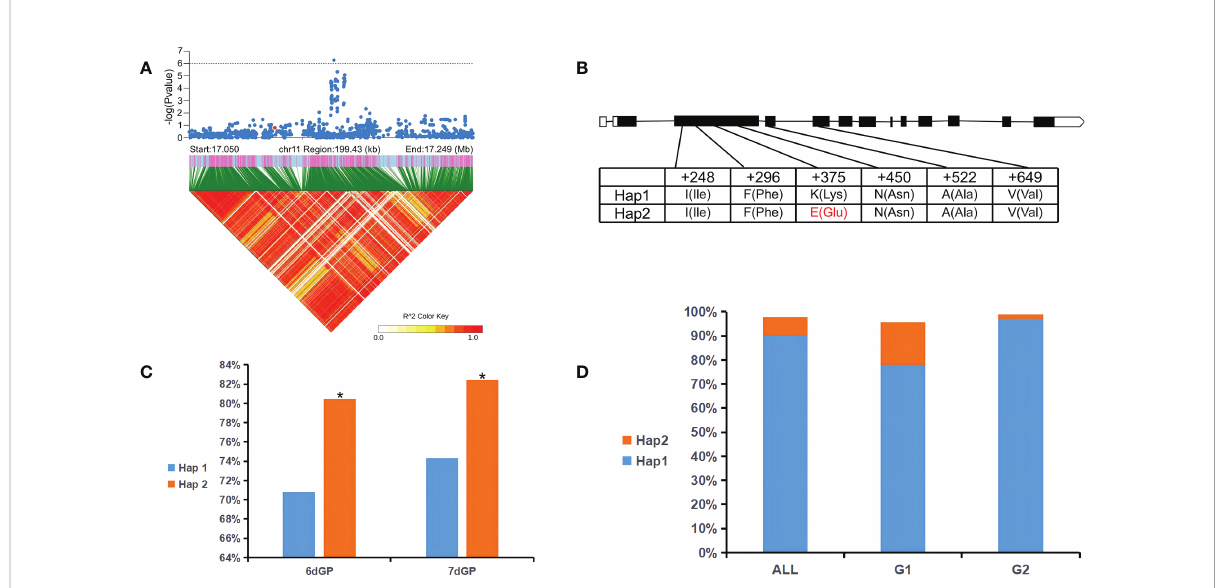
FIGURE 4 LOC_Os11g29490 haplotype signi fi cance analysis. (A) Partial Manhattan map (top) and LD heatmap (bottom) around the peak of chromosome 11. The red dot indicates the position of a missense variation in LOC_Os11g29490 . (B) Gene structure and polymorphism in LOC_Os11g29490 . (C) Signi fi cance analysis of Hap1 and Hap2 among germination potential (GP) for all germplasm (All). (D) Distribution of Hap1 and Hap2 in All and in subpopulations G1 and G2. * p < 0.05 (Student ’ s t